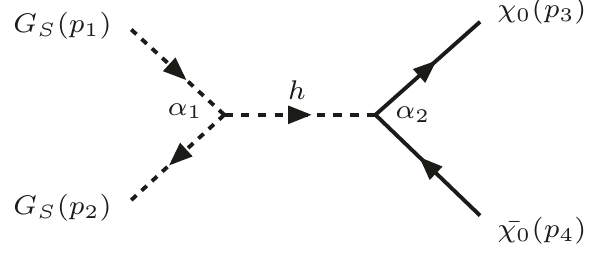
Figure 10 . Feynman graph for pNBG ( G s ) annihilation to neutralino ( (cid:31) 0